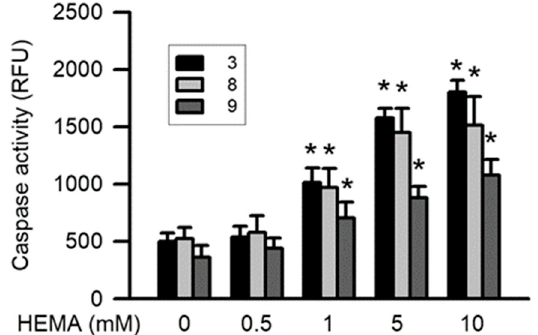
Figure 4. HEMA induced activation of caspase-3, caspase-8, and caspase-9 in RAW264.7 macrophages. Activation of caspase-3 (black column), caspase-8 (gray column), and caspase-9 (dark gray column) was measured by the caspase fluorometric assay kits after 24 h of HEMA incubation. Data are expressed as means ± SD. The number of parallel measurements is 5. * means that p < 0.05 compared with HEMA at the concentration of 0 mM.